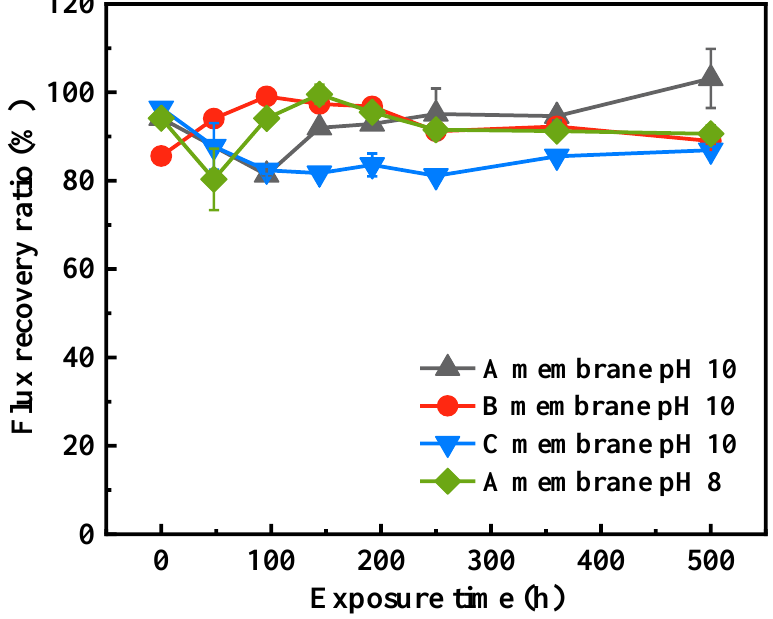
Figure 7. Flux recovery ratios of NaOCl-aged membranes as a function of exposure time.